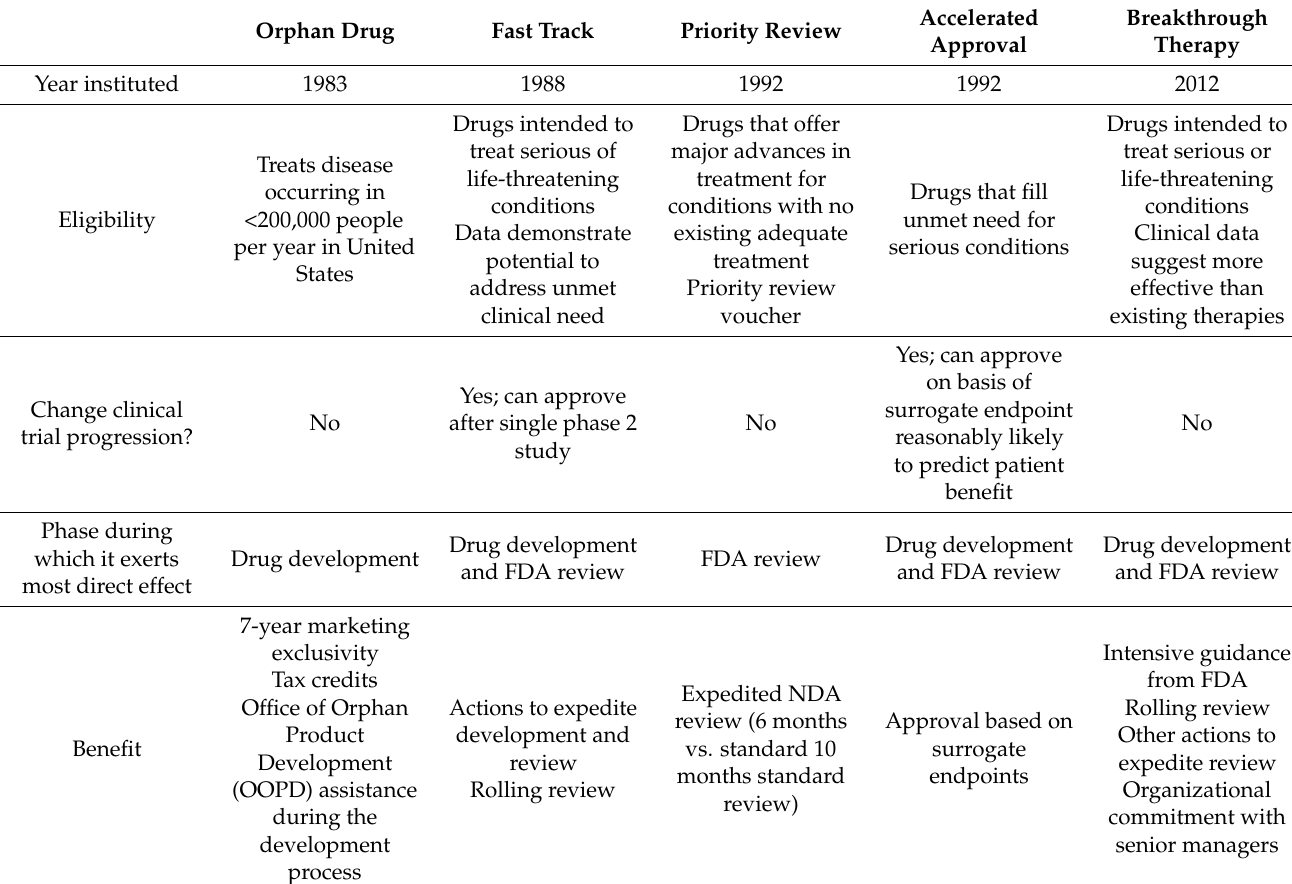
Table 1. Summary of FDA Expedited Development and Review